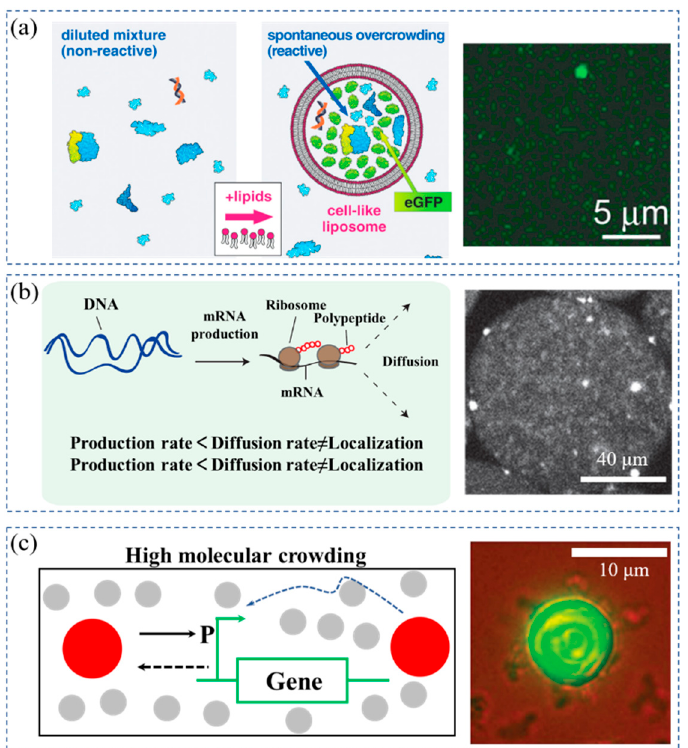
Figure 4. ( a ) A spontaneous concentration of all components of the mixture inside vesicles by spontaneous formation of liposomes, enabling protein synthesis. Reprinted with permission from Ref. [45] 2013, John Wiley and Sons. ( b ) Inhomogeneous distribution of mRNA over one droplet at high ficoll concentrations. Reprinted with permission from Ref. [46] 2015, Springer Nature. ( c ) Enhancement of gene expression in artificial cells by crowding effect. Reprinted with permission from Ref. [47] 2013, Springer